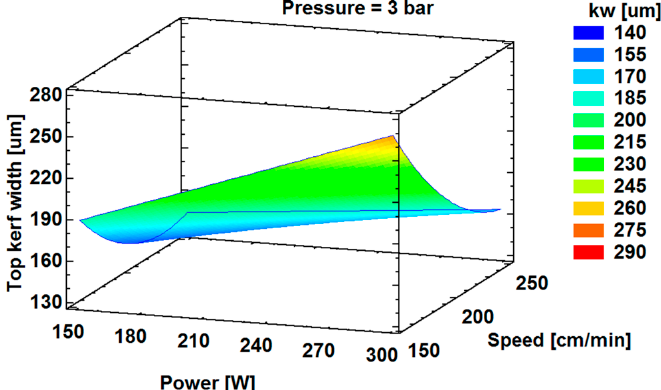
Figure 11. Response surface plot for the effects of the cutting parameters on top kerf width (kw). Oxygen pressure 3 bar.